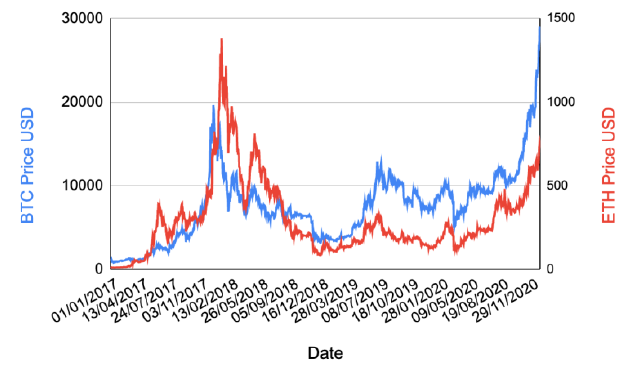
Figure 2 : Bitcoin (BTC) and Ether (ETC) Price in United States Dollars (USD).